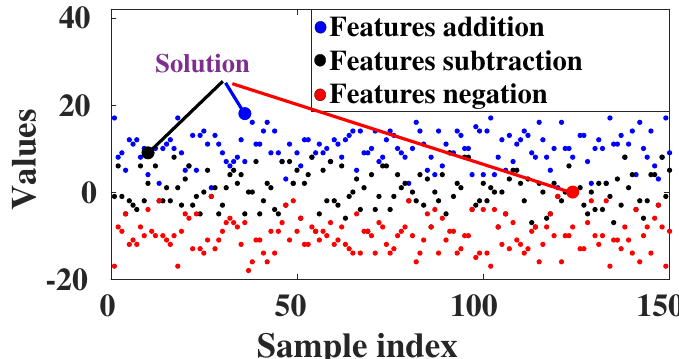
Figure 4. Objective evaluation based on various feature combinations, where the enlarged circle represents the solution for a particular